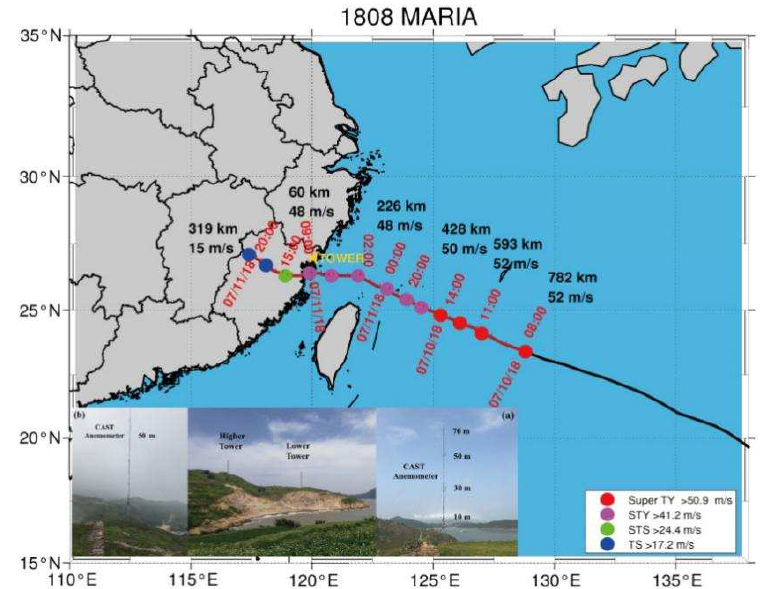
Figure 1. Track of Typhoon Maria and the location, exposure, and instruments on the two eddy covariance flux towers. The coastal observation towers are marked by the yellow arrow. ( a ) Photo- graph of the coastal observation tower approximately 10 m from the coastline (Figure 1a), which is referred to as the lower tower in this study. The CAST anemometers on the lower tower are 10, 30, 50, and 70 m above the ground (60, 80, 100, and 120 m above sea level). ( b ) Photograph of the coastal observation tower at the top of the hill, which is referred to as the higher tower in this study. The CAST anemometers on the higher tower are 50 m above the ground (170 m above sea level).